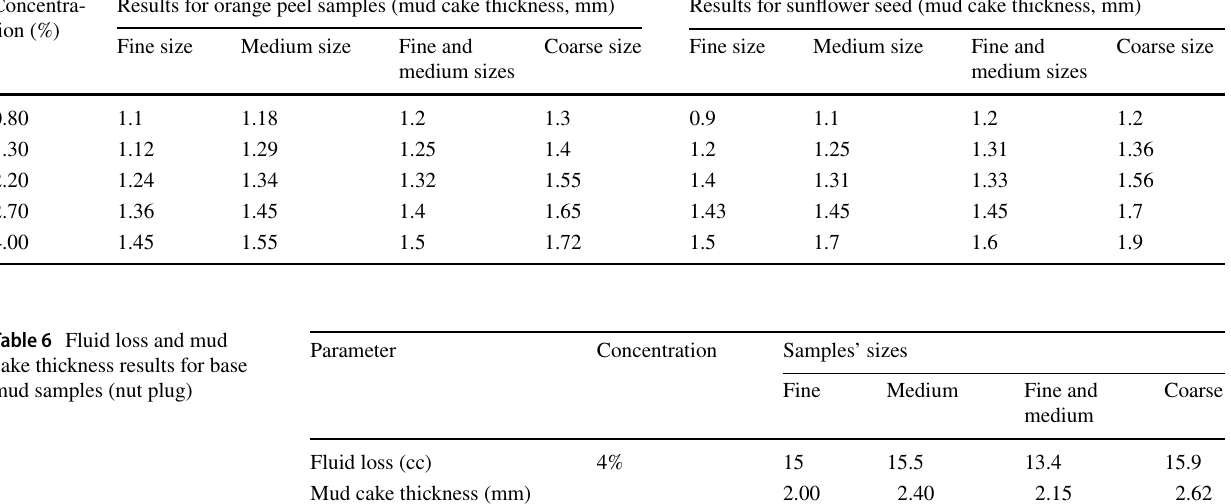
Table 5 Mud cake thickness results for orange peel and sunflower seed samples Concentra- tion (%)